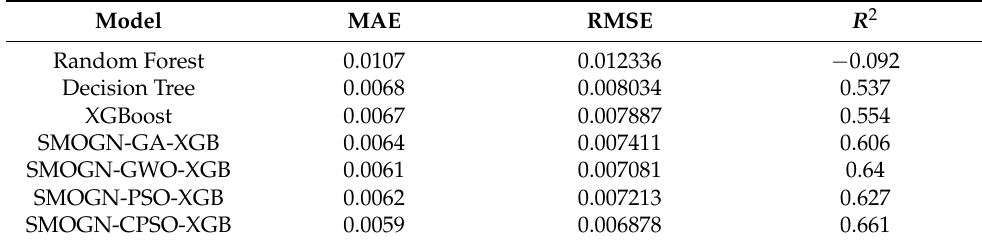
Table 4. Performance metrics of various models.